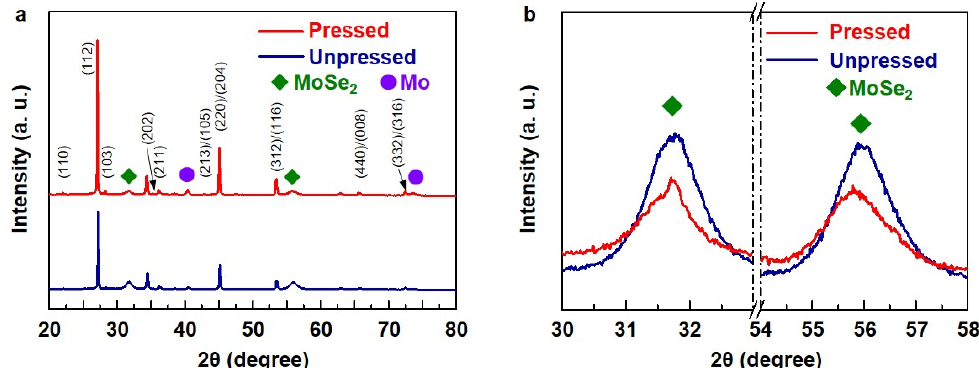
Figure 6. ( a ) XRD patterns of CZTSe solar cells with unpressed (bottom) and pressed absorber layers (top) (green diamond labels indicate diffraction peaks of MoSe 2 , and purple circle labels indicate those of Mo) and ( b ) magnified XRD patterns of MoSe 2 (blue line represents the unpressed cell, and red line represents the pressed cell).